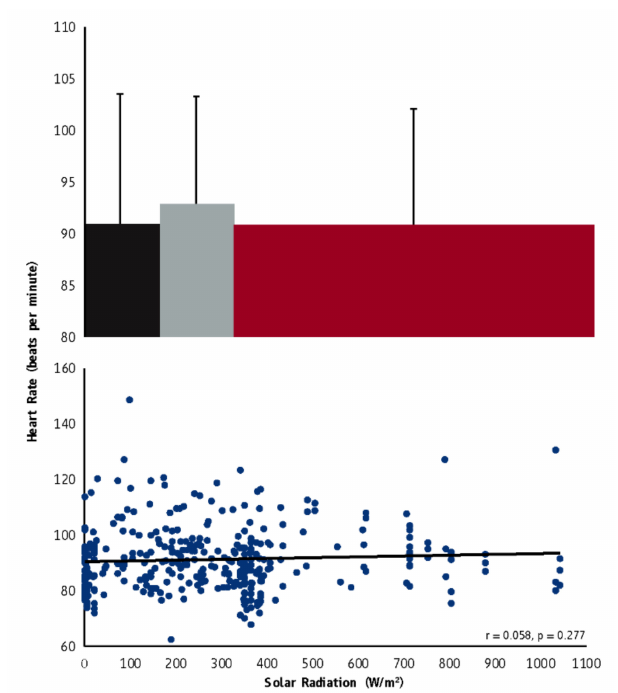
Figure A2. The average ( ± SD) heart rate in indoor (black), mixed (grey), and outdoor (red) environ- ments characterized by the same thermal stress (top graph) as well as the association between hourly heart rate and solar radiation (bottom graph). Bar width in the top graph indicates the range of solar radiation of each category corresponding to the horizontal